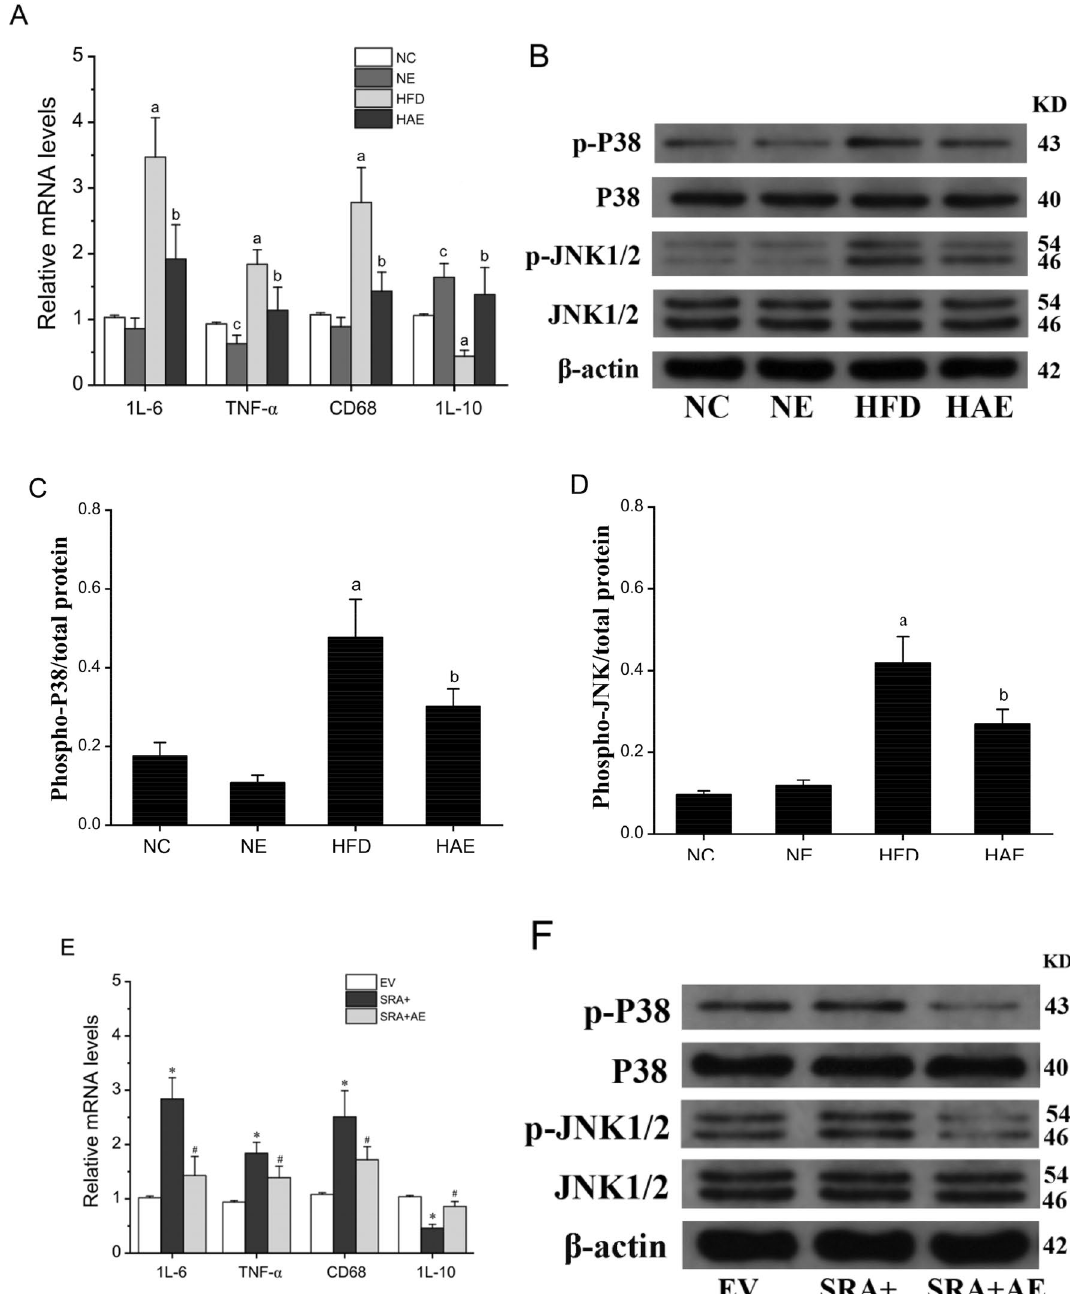
Figure 4. Aerobic exercise improves P38/JNK-mediated inflammation through SRA. ( A ) The mRNA levels of inflammatory factors in mice liver assessed by RT-qPCR, n = 6/group. ( B ) Western blot analysis of protein expression and phosphorylation of P38 and JNK. ( C ) The phosphorylated P38/total protein levels in the liver of each group of mice. ( D ) The Phosphorylated JNK/total protein levels in the liver of each group of mice. a P < 0.05 vs. NC group; b P < 0.05 vs. HFD group; c P < 0.05 vs. NC group. ( E ) The mRNA levels of inflammatory factors in the liver of EV, SRA+, SRA + AE mice were assessed by RT-qPCR, n = 6/group. ( F ) Western blot analysis of protein expression and phosphorylation of P38 and JNK in EV, SRA+, SRA + AE mice. ( G ) The phosphorylated P38/total protein levels in the liver of each group of mice. ( H ) The Phosphorylated JNK/total protein levels in the liver of each group of mice. (I) The expression of PERK activity in mice liver, n = 6/group. ( J ) The expression of IRE1a activity in mice liver, n = 6/group. a P < 0.05 vs. NC group; b P < 0.05 vs. HFD group; * P < 0.05 vs. EV group; # P < 0.05 vs. SRA + group. The values represent the means ± SD. Abbreviations: NC, normal control group; NE, normal aerobic exercise group; HFD, high-fat diet group and HAE, high-fat diet with aerobic exercise group; EV virus empty vector group; SRA+, SRA overexpression group; SRA + AE, SRA overexpression and combined with the aerobic exercise